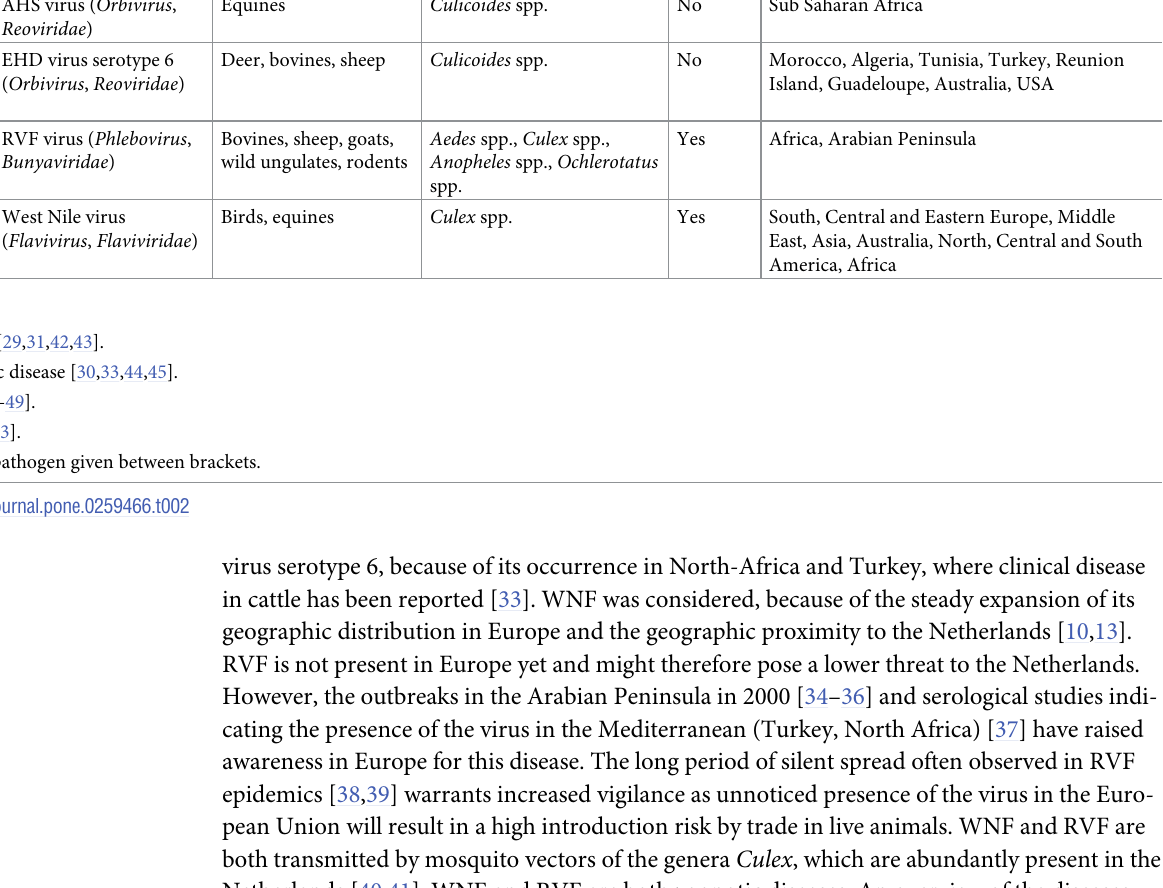
Table 2. Overview of causing pathogens, vertebrate host animals, arthropod vectors, and geographical distribution of four vector-borne diseases a .